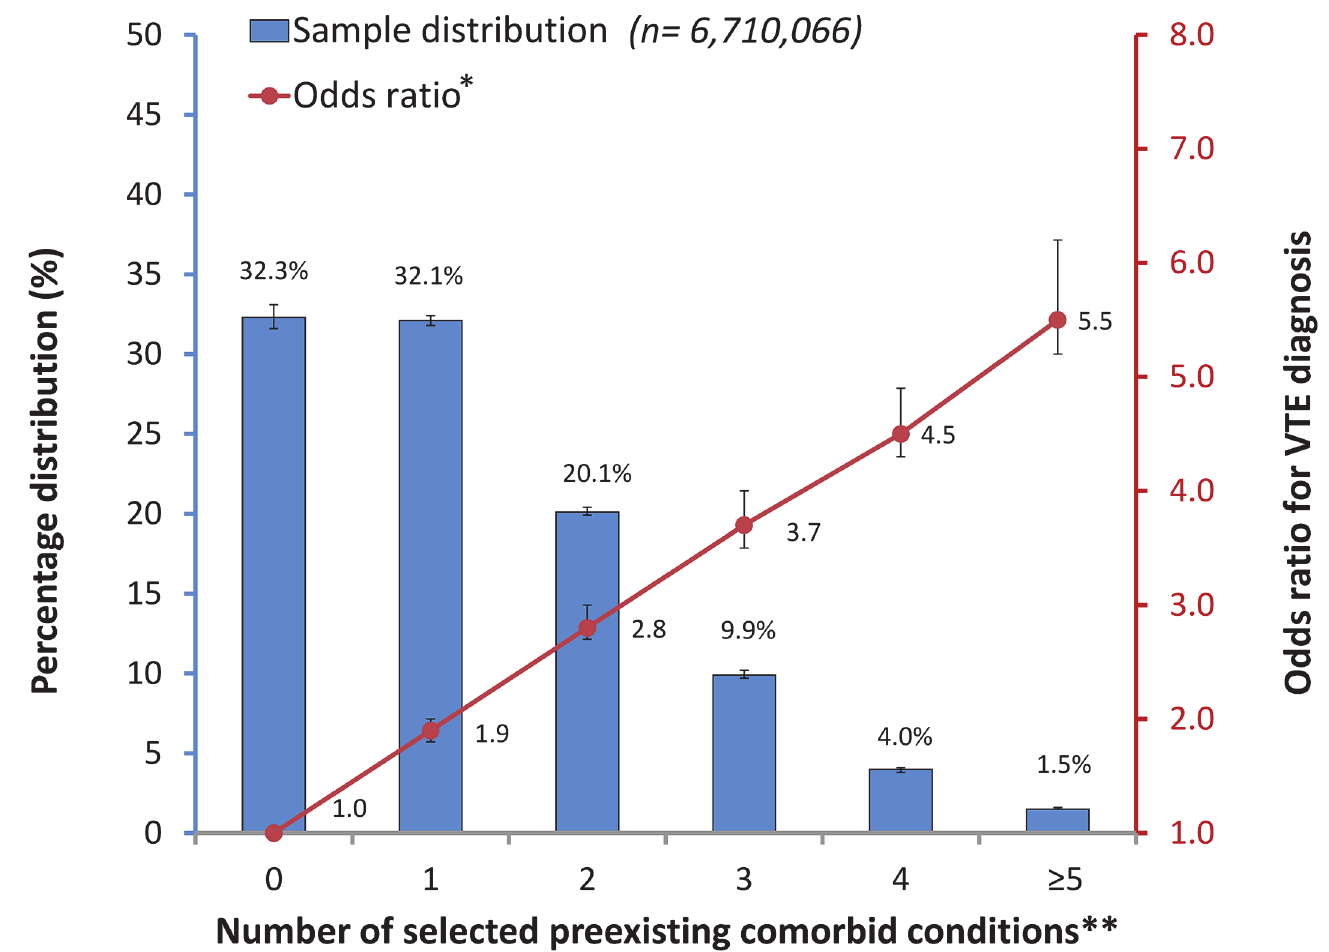
Fig 2. Percentage distribution of hospitalizations of US adults and odds ratios for VTE diagnosis by number of selected preexisting comorbid conditions, NIS, 2011.